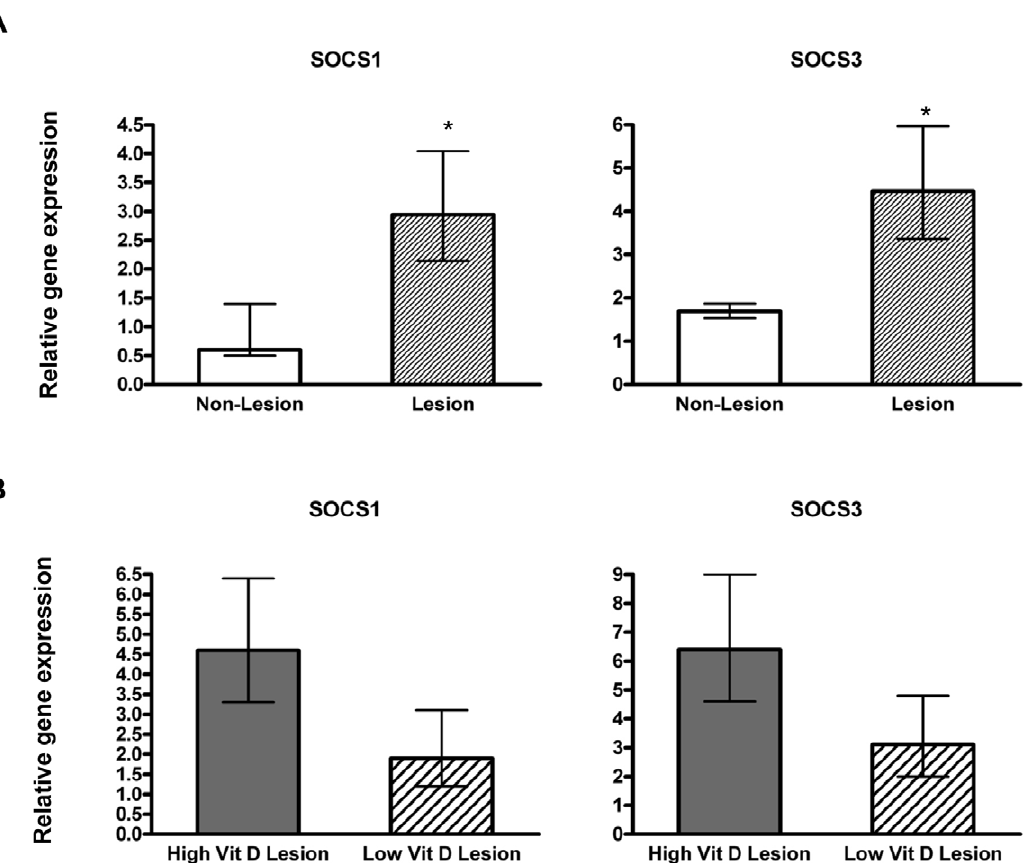
Figure 8. SOCS1 and SOCS3 gene expression in lung tissues of calves following bovine RSV experimental infection. ( A ) Suppressors of cytokine signaling (SOCS) 1 or SOCS3 mRNA levels in lesioned or non-lesioned lung samples from bovine RSV-infected calves irrespective of vitamin D treatment (n=16). ( B ) Suppressors of cytokine signaling (SOCS) 1 or SOCS3 mRNA levels in lesioned lung samples from bovine RSV-infected calves with low (n=8) or high (n=8) circulating 25(OH)D 3 levels. The amount of each target gene was determined by quantitative real-time PCR with normalization to RPS9. The relative amount of each target gene was determined using the 2 2 DD Ct method. DD Ct values 6 SE were transformed (2 2 DD Ct ) and data are presented as the target gene expression relative to control lung samples (n=4). Statistical analysis was performed using Student’s t-test. DD Ct values were used in the analysis of relative gene expression. *P , .05.